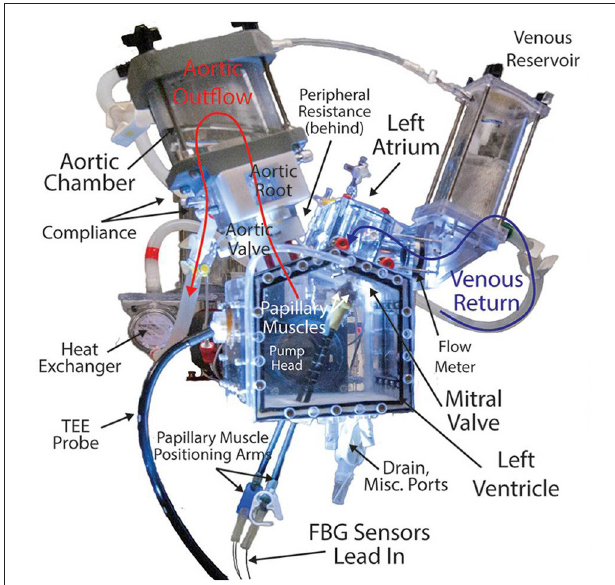
FIGURE 1 | Detailed, labeled image of a left heart simulator. This system uses explanted large animal heart valves and a piston pump to generate and measure physiologic pressures and flows through the valves to study disease pathologies, repair techniques, and surgical devices. Simulators such as these provide useful platforms for modeling heart valve biomechanics and represent a promising new class of research in this field, directly informing clinical understandings and